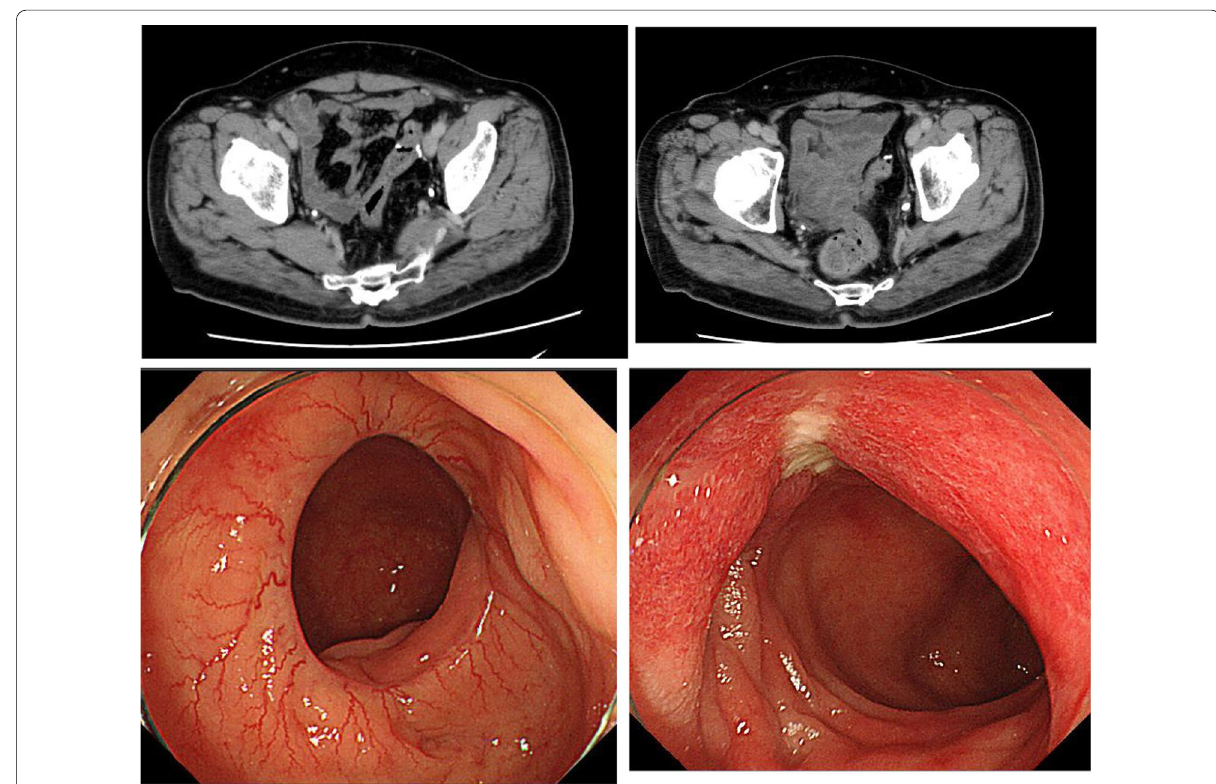
Fig. 6 Computed tomography and colonoscopy findings after non-operative management. Computed tomography was performed on the 46th day and colonoscopy on the 35th day. Edematous changes and circumferential ulcers show